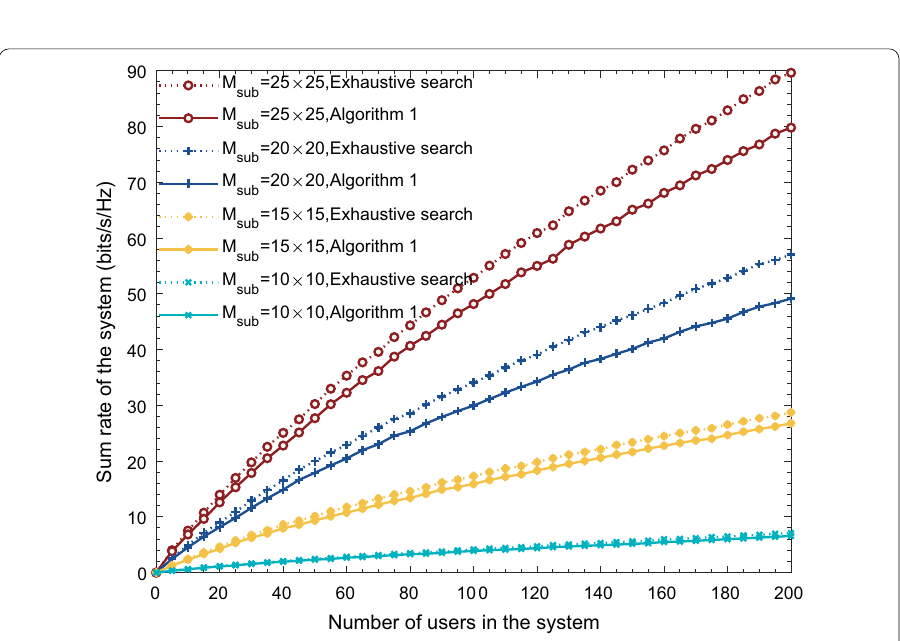
Fig. 4 Comparison of sum rates in the